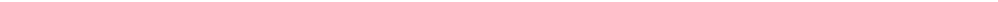
Figure 1: (a) Pie-chart with proportional distribution of 65 emm types of Streptococcus dysagalactiae isolates causing bacteraemia in adults over a 10-year period. Each colour represents one emm type. Two isolates were not available for emm type determination (na). One isolate was not typable (nt). (b) Distribution of emm types of S. dysgalactiae isolates causing 19 episodes of bacteraemia in 16 patients with intra- venous drug use. Each square represents an episode, each colour a specific emm type. One isolate was not available for emm type analysis (na, grey colour). The date of bacteraemia is indicated within each square. In three female patients two episodes of bacteraemia with 67 days interval (4 Oct and 10 Dec 2008), 210 days interval (29 May and 26 Dec 2008), and 269 days interval (6 Oct 2009 and 02 Jul 2010), respec- tively, occurred. In 2012, four episodes in four patients (three women, one man) with two emm types was